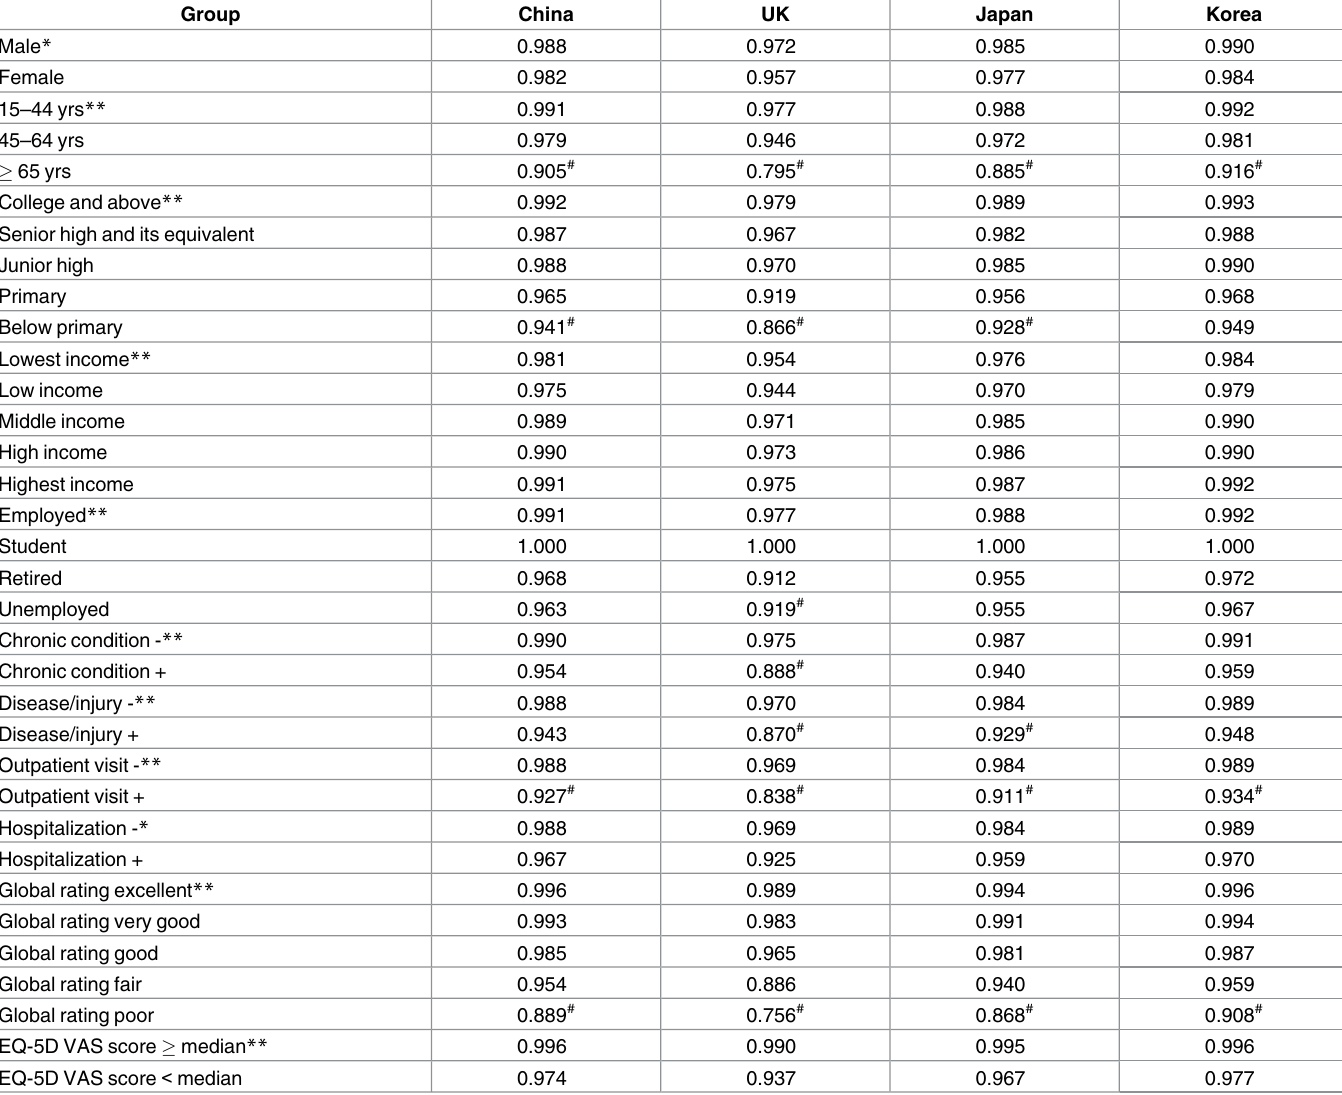
Table 4. Known-groups validity of the EQ-5D index scores using China, UK, Japan and Korea weights.